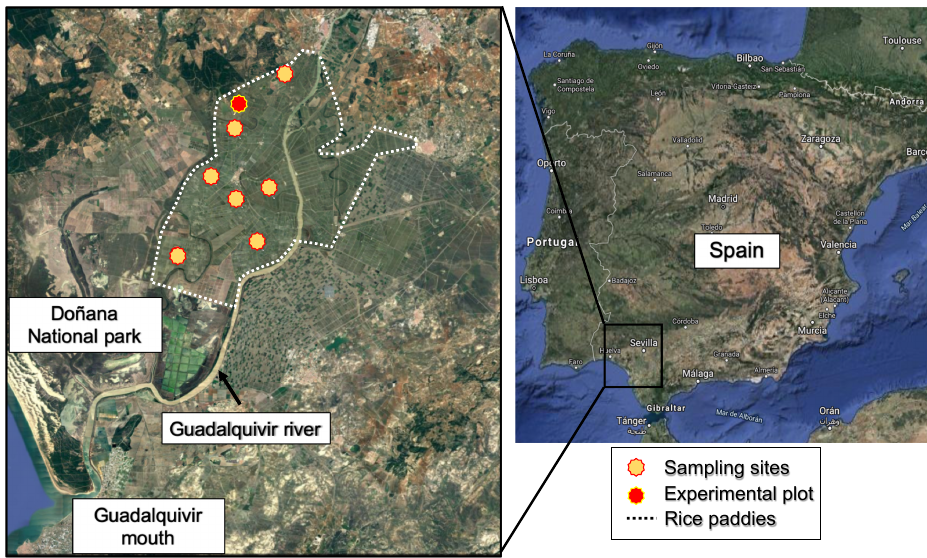
Figure 1. Location of the sampling points selected for this study. In red, location of the experimental plot selected for the field